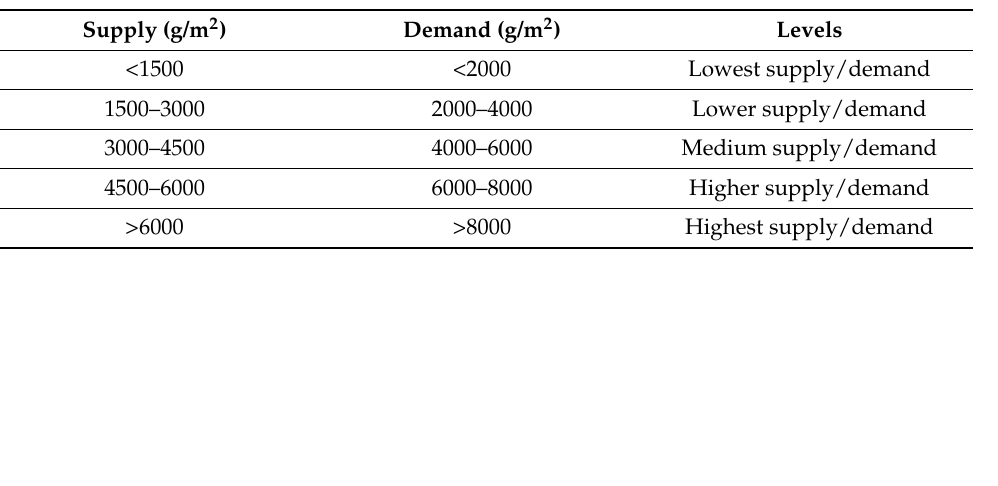
Table 2. Five levels of supply and